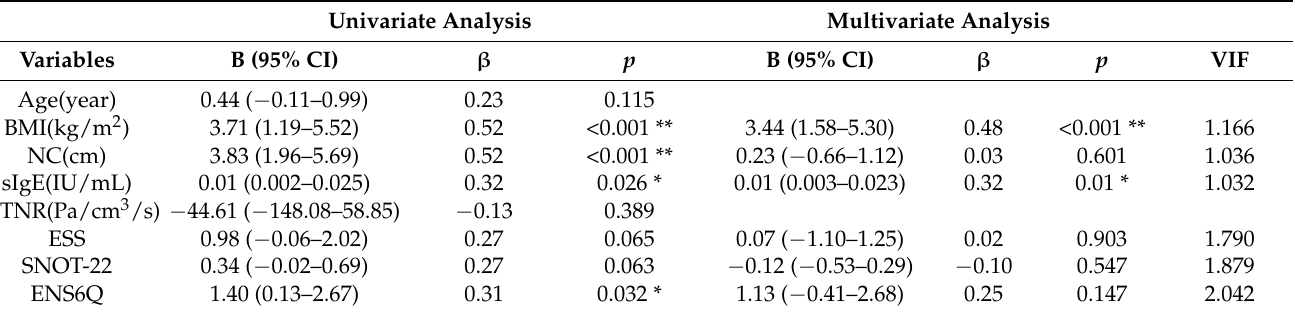
Table 3. Linear regression analysis for an apnoea–hypopnoea index of the study participants. Univariate